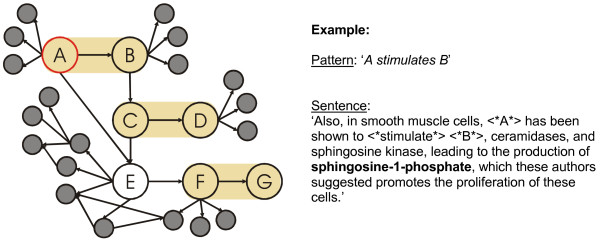
Example of interaction network.